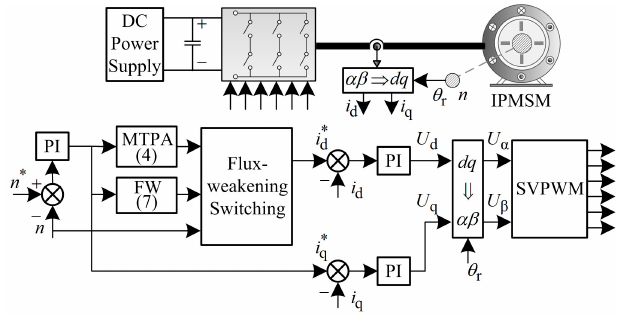
Figure 1. The traditional control strategy based on PI controller.